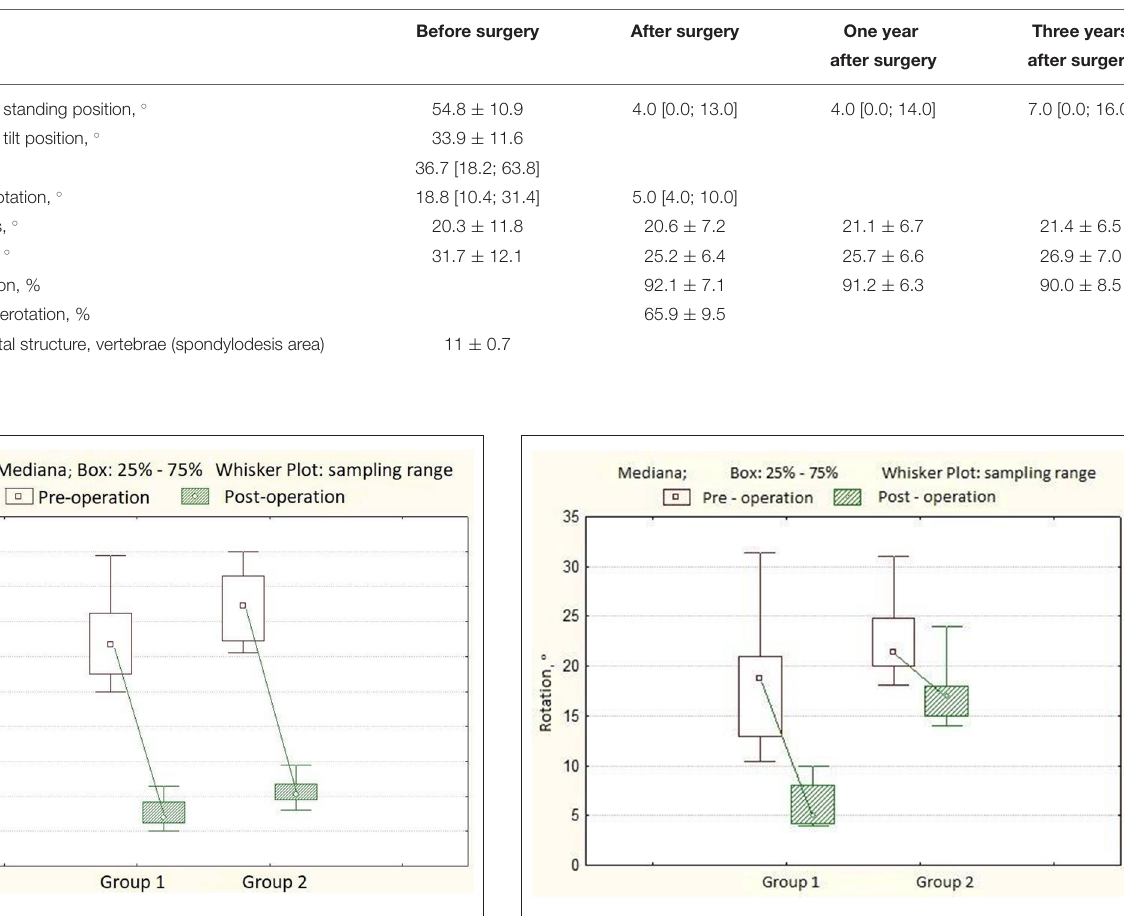
FIGURE 2 | A boxplot showing the dynamics of the angles of rotation of the apical vertebra in patients from groups 1 and 2.